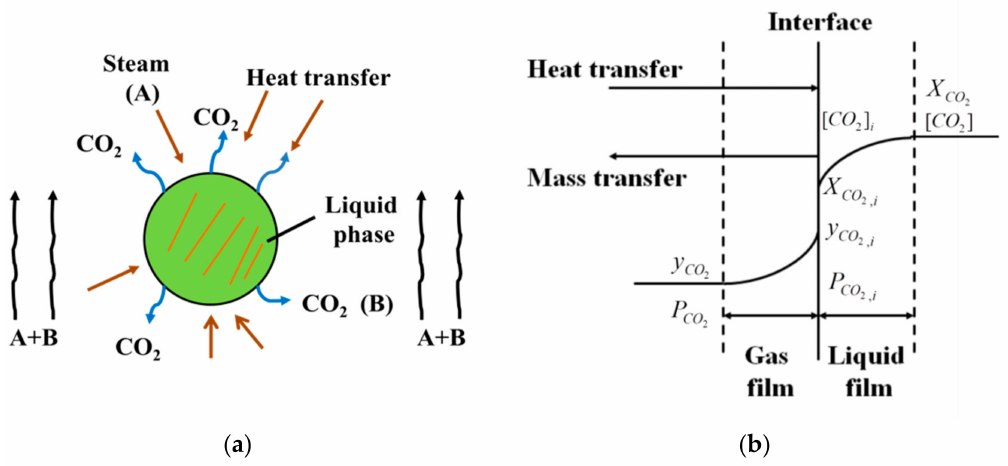
Figure 1. Steam and liquid drop contact within the packed-bed stripper. ( a ) Particle model, ( b ) two-film